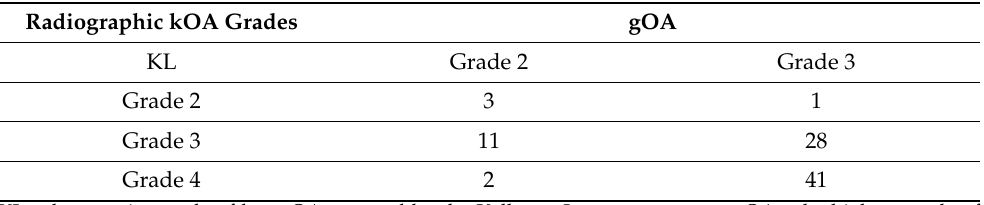
Figure A3. The association of preoperative uC2C levels with uni- or bilateral kOA status. U WG (unilateral kOA without previous TKR in the whole group); B WG (bilateral kOA with previous TKR in the whole group); U Male (unilateral kOA without previous TKR in males); B Male (bilateral kOA with previous TKR in males); U Female (unilateral kOA without previous TKR in females); B Female (bilateral kOA with previous TKR in females). Boxplot with 10th–90th percentiles, Wilcoxon test p -values. Table A1. Distribution of radiographic grades of kOA evaluated by two different systems: KL and NSy.